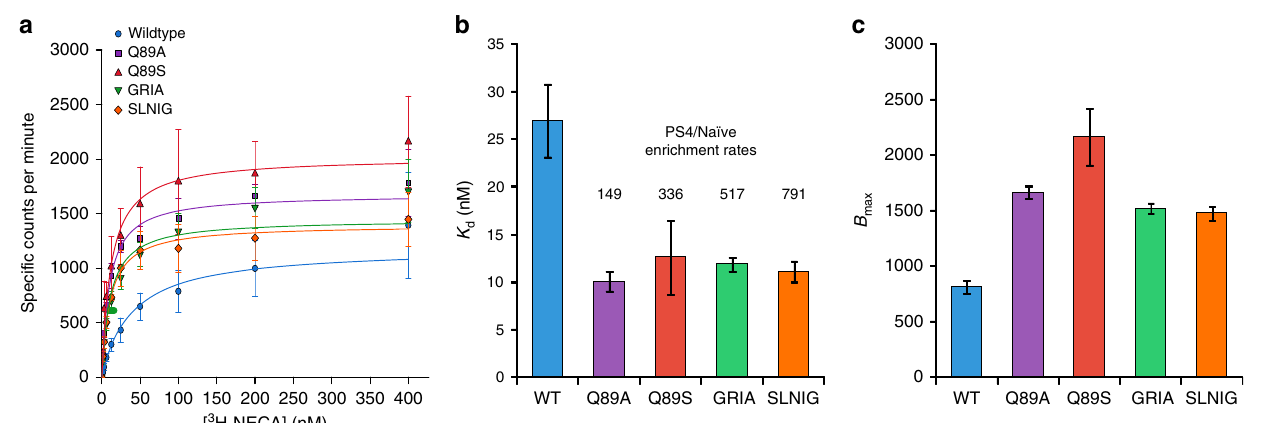
Fig. 4 Radioligand binding con fi rms improved ligand-binding af fi nities. a , b Compared with wild-type A 2 aR, highly enriched variants, Q89A/S, GRIA, and SLNIG bind [ 3 H]-NECA with fourfold greater af fi nity ( K d ). c Functional yields ( B max ) of the highly enriched variants are 1.2 – 1.7-fold of the wild-type receptor yield, suggesting improvements in ligand-binding af fi nity rather than functional yield dictate variant enrichment. Data represent the mean of three biological replicates, and error bars represent their standard deviation. Source Data are provided as a Source Data fi le.